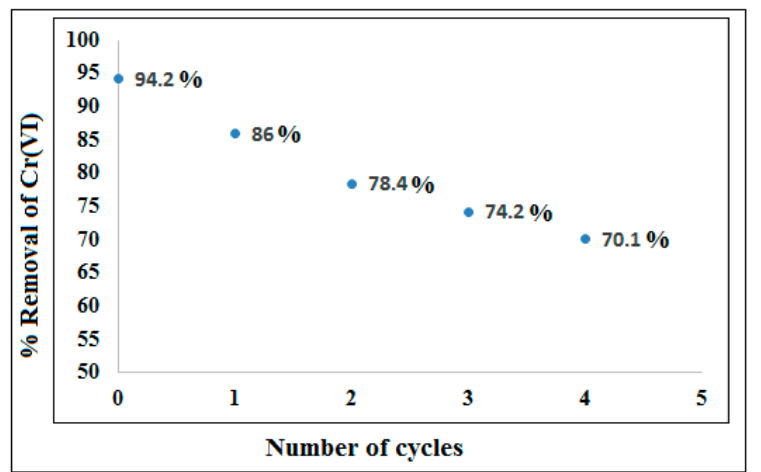
Figure 8. % Removal of Cr(VI) from the prepared Al-GNSC adsorbent and regenerated adsorbent of several cycles.